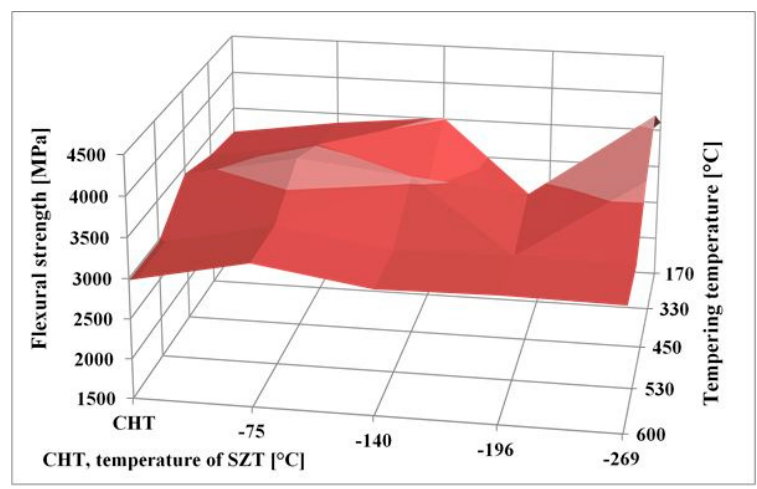
Figure 9. Comparison of the obtained flexural strength values for differently sub-zero treated and tempered specimens made of the Vanadis 6 steel.